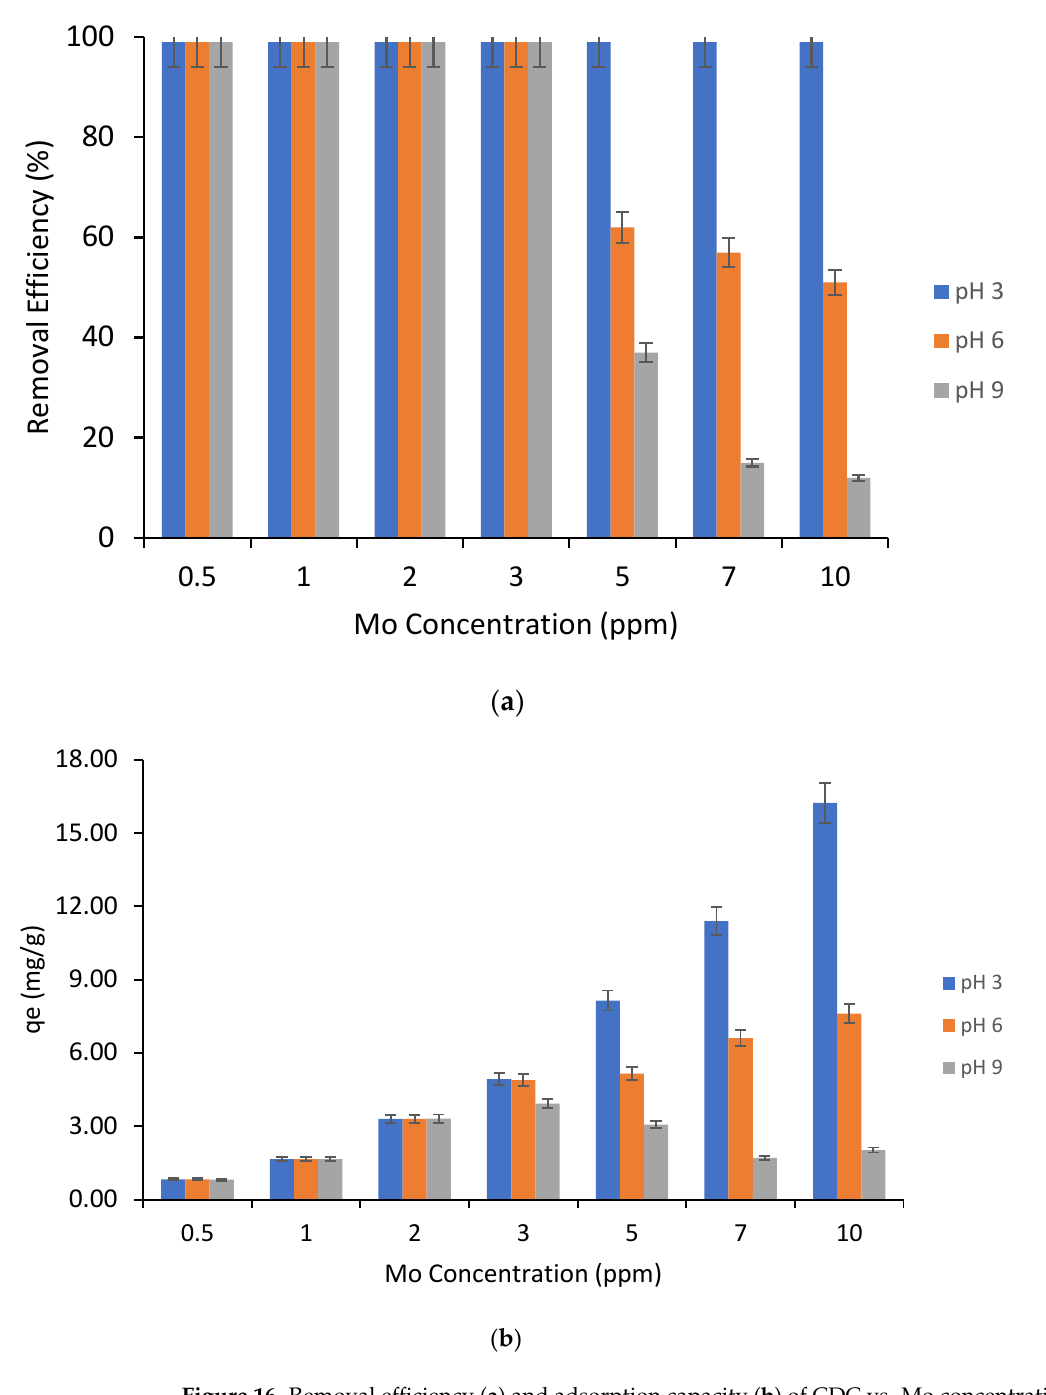
Figure 16. Removal efficiency ( a ) and adsorption capacity ( b ) of CDC vs. Mo concentration (ppm) at different pH levels (3, 6, and 9); CDC loading: 0.6 g/L; agitation speed: 150 RPM.